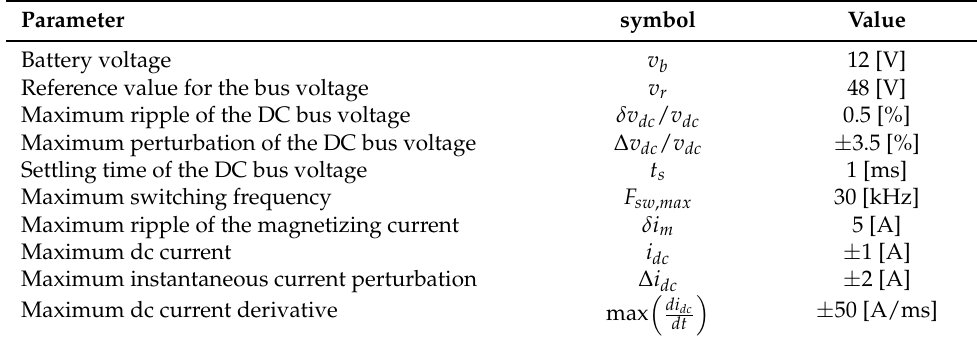
Table 1. Parameters for the application